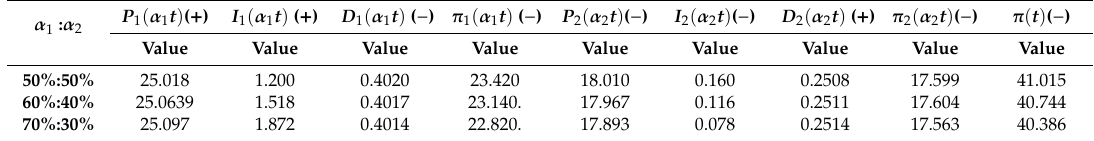
Table 3. Sensitivity analysis of t = 60 h. Unit: million NT$.